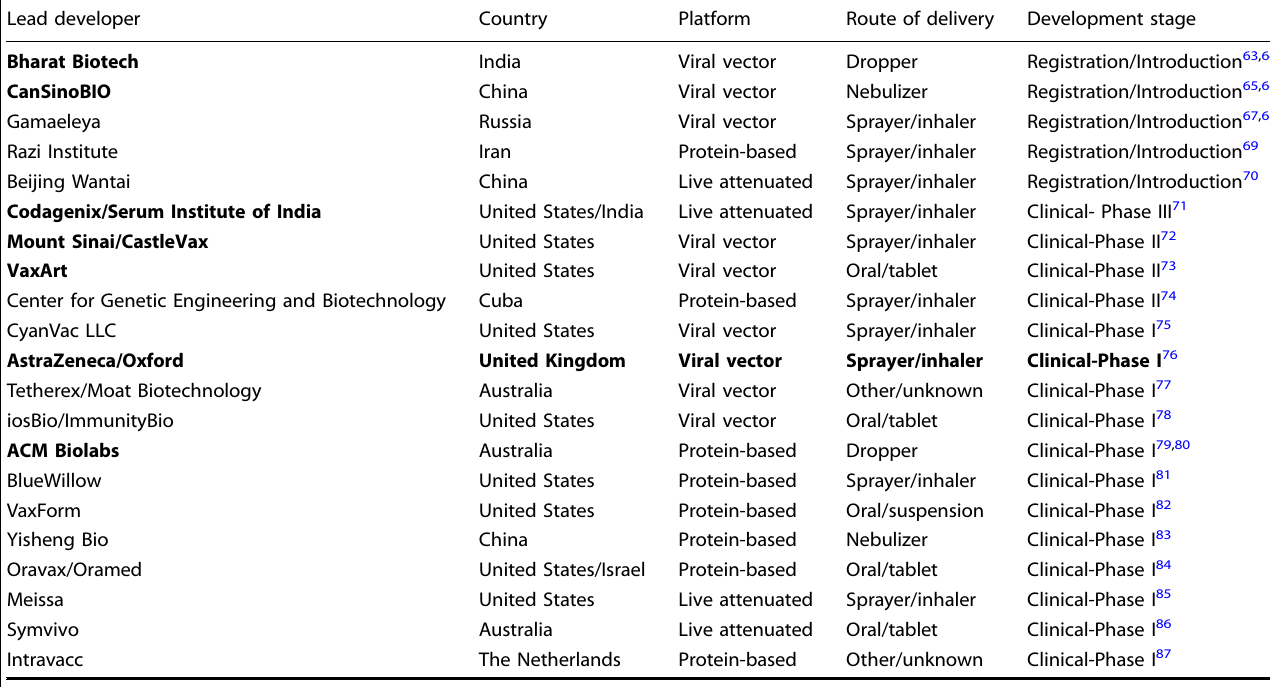
Table 1. List of SARS-CoV-2 mucosal vaccine candidates in use or in clinical development. Lead